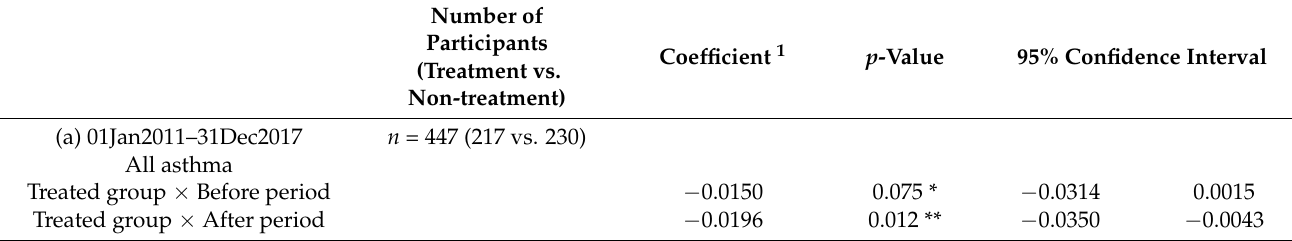
Table A5. Predicted coefficient of the interaction term of treated groups and period stratified by Medicaid enrollment